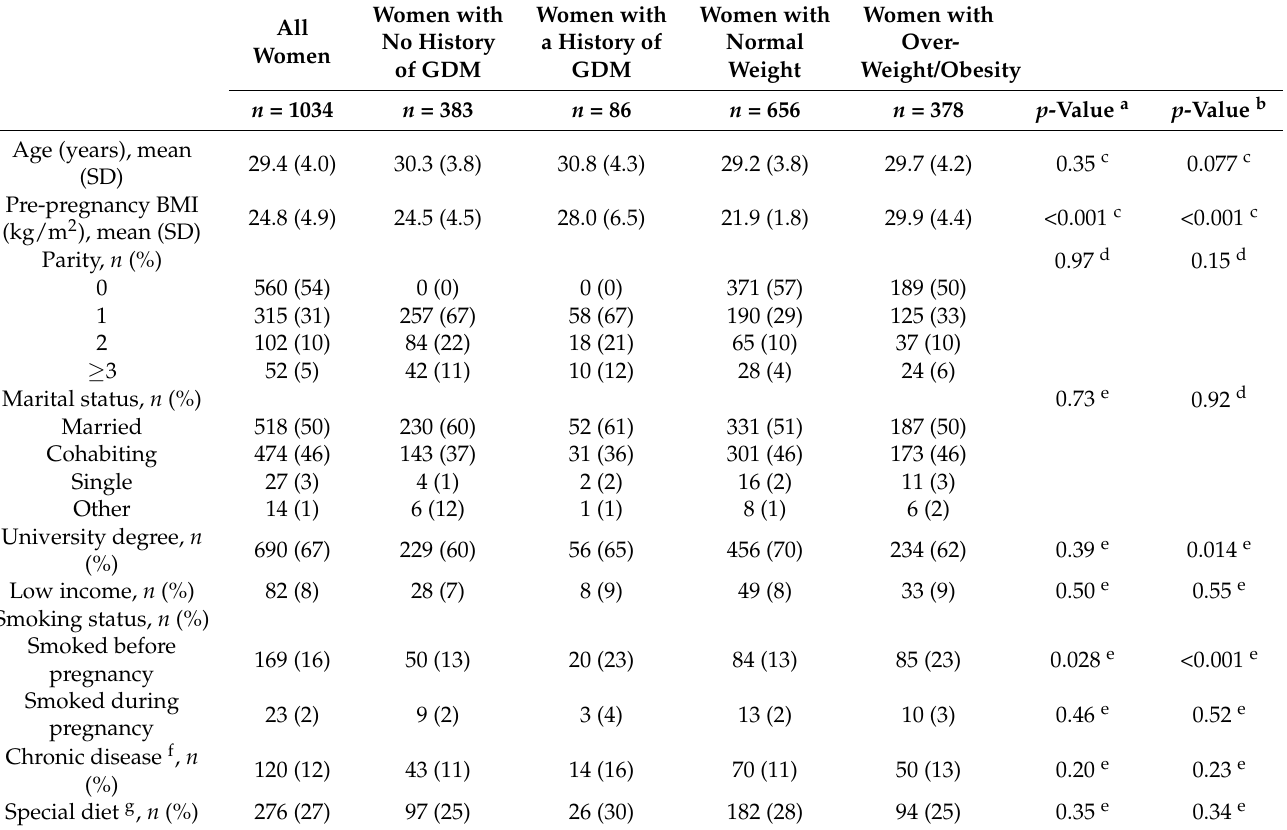
Table 1. Clinical characteristics of the women subdivided by history of gestational diabetes or their pre-pregnancy BMI values.